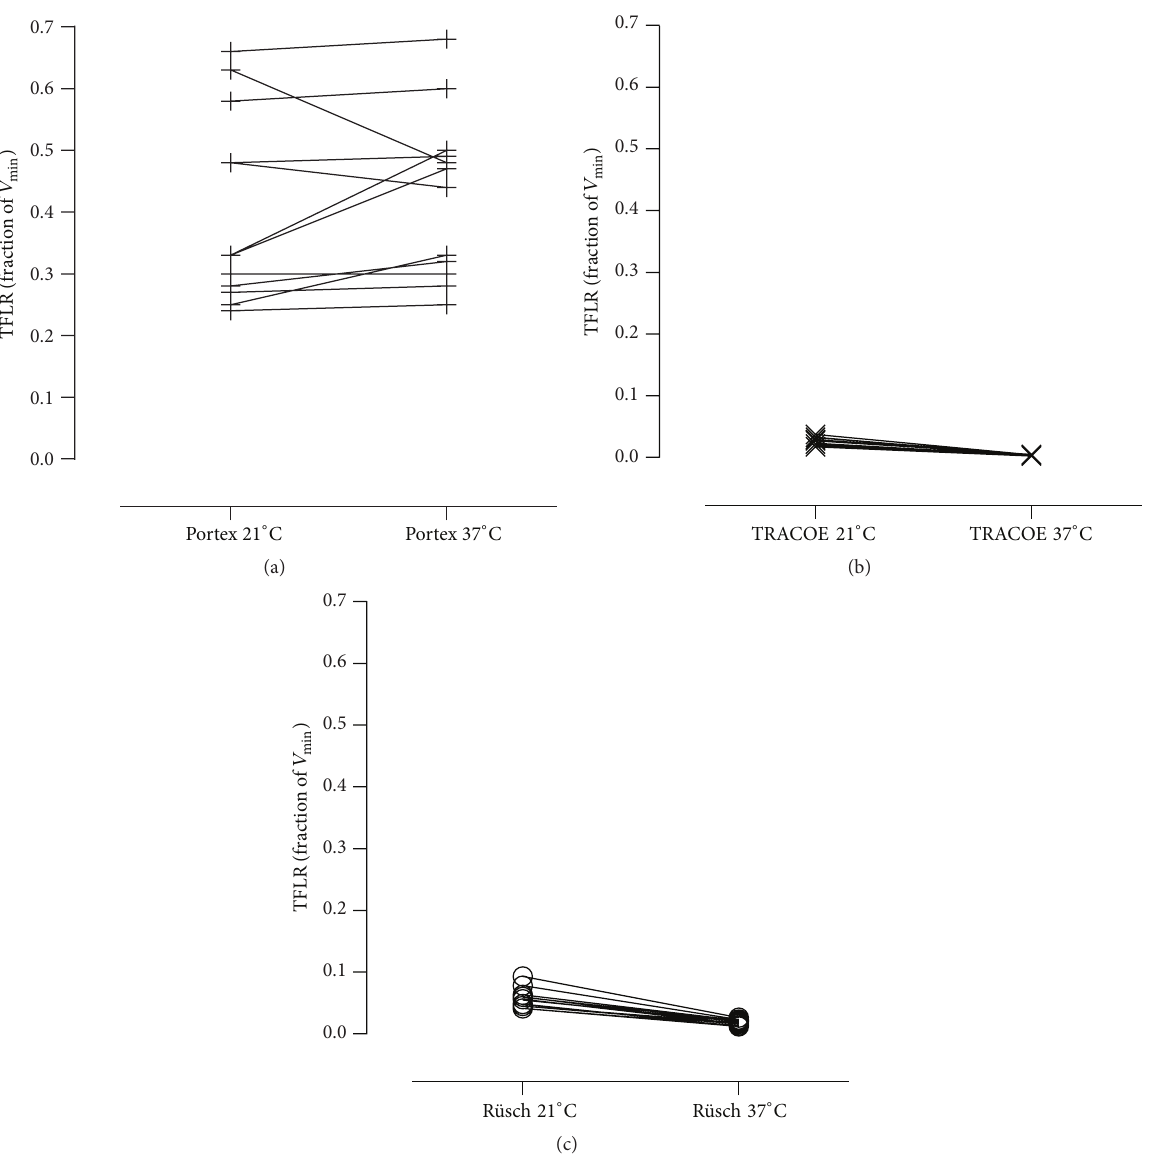
Figure 3: Transfenestration leakage rates of Portex Blue Line Ultra (+), TRACOE twist ( × ), or R¨usch Traceofix ( I ) tracheostomy tubes. Measurements were performed at 21 ± 1 ∘ C or 37 ± 1 ∘ C. TFLR: transfenestration leakage rate; 𝑉 min : minute ventilation.